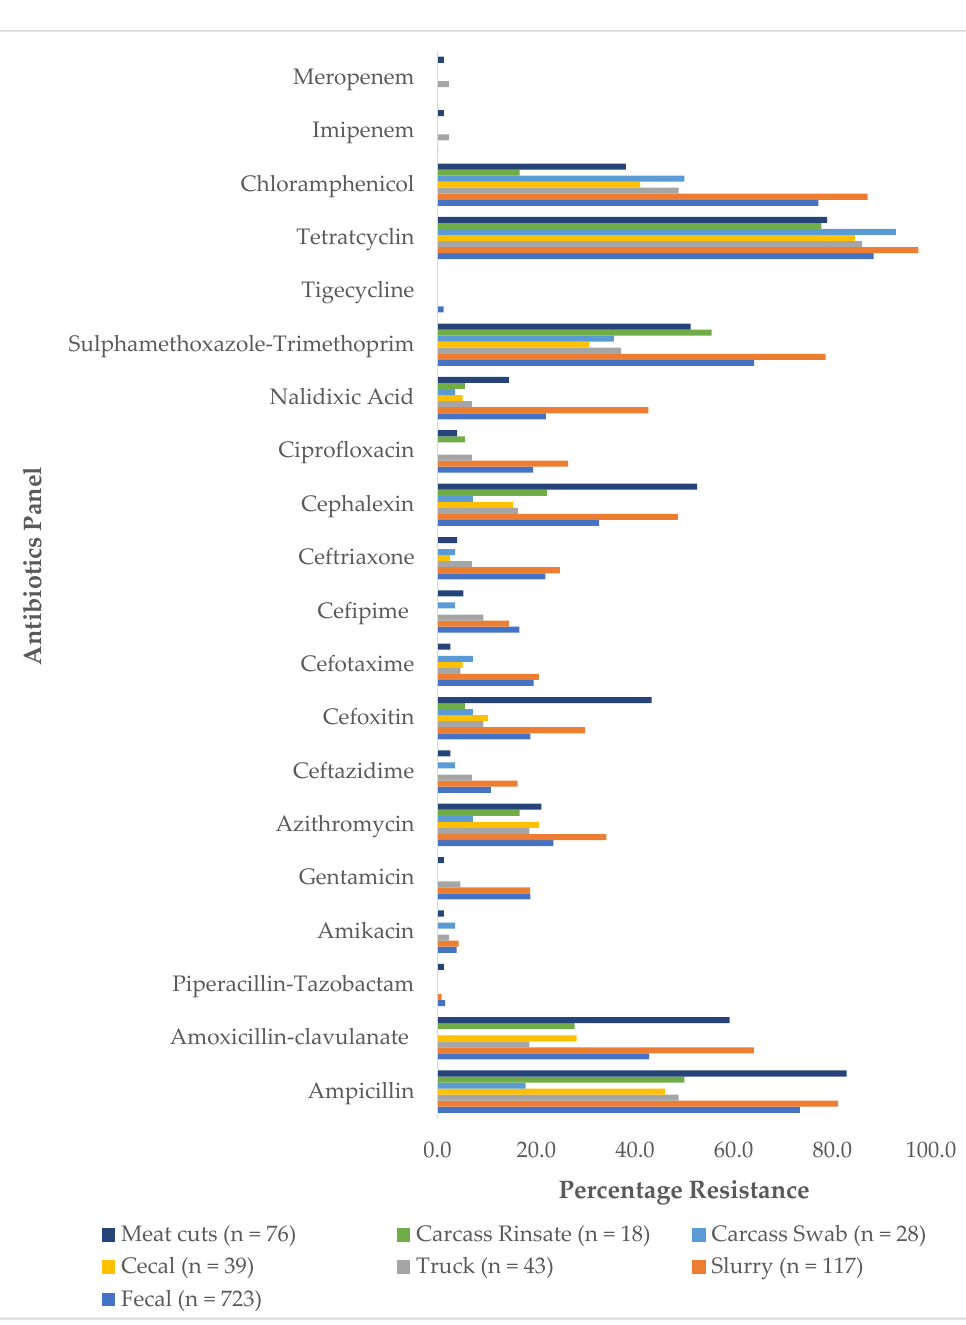
Figure 3. Percentage antibiotic resistance among isolates, stratified by source. The overall multidrug resistance (MDR) rate was 71.2% ( n = 743). The highest preva- lence of MDR was found on the farm 74.6% ( n = 723) while truck and abattoir MDR rate was 51.1% ( n = 43) and 50.3% ( n = 161), respectively (Table 1). The difference in the MDR The MAR indices ranged from 0.1 to 0.9. The lowest MAR index recorded among all rate between the different sampling sites was statistically significant (Table 1). None of the isolates was 0.1 (resistance to two antibiotics), and this was found in 15.2% ( n = 157) of the isolates were pan-drug resistant (Table 1). Two hundred and two (202) MDR patterns the total isolates. The highest MAR index was 0.9 (resistance to 18 antibiotics), recorded were recorded in the study, the most common pattern being AMP-SXT-TET-CHL, found in 0.1% ( n = 1) of the farm isolates. The highest MAR indices recorded in transport and in 4.7% ( n = 49) of the isolates (Table 1). abattoir were 0.7 and 0.75, respectively (Figure